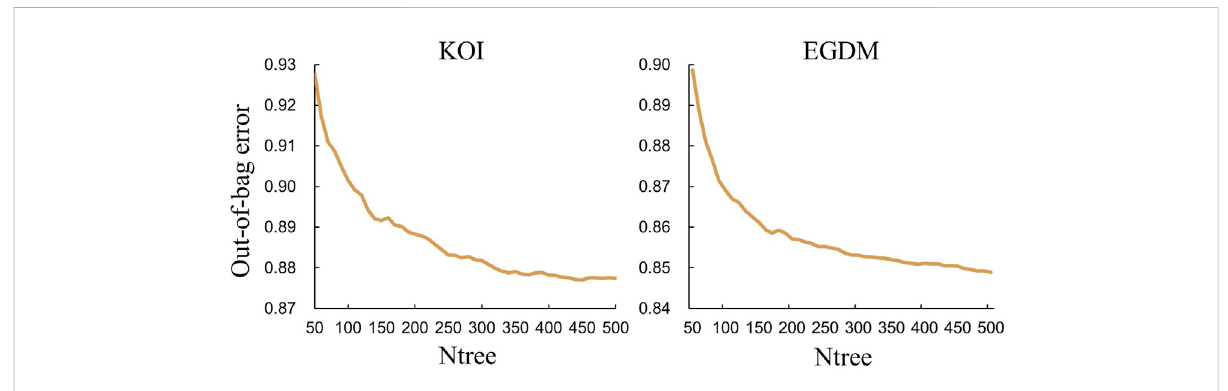
FIGURE 6 The out-of-bag error of the RF-RN models at stations KOI and EGDM.